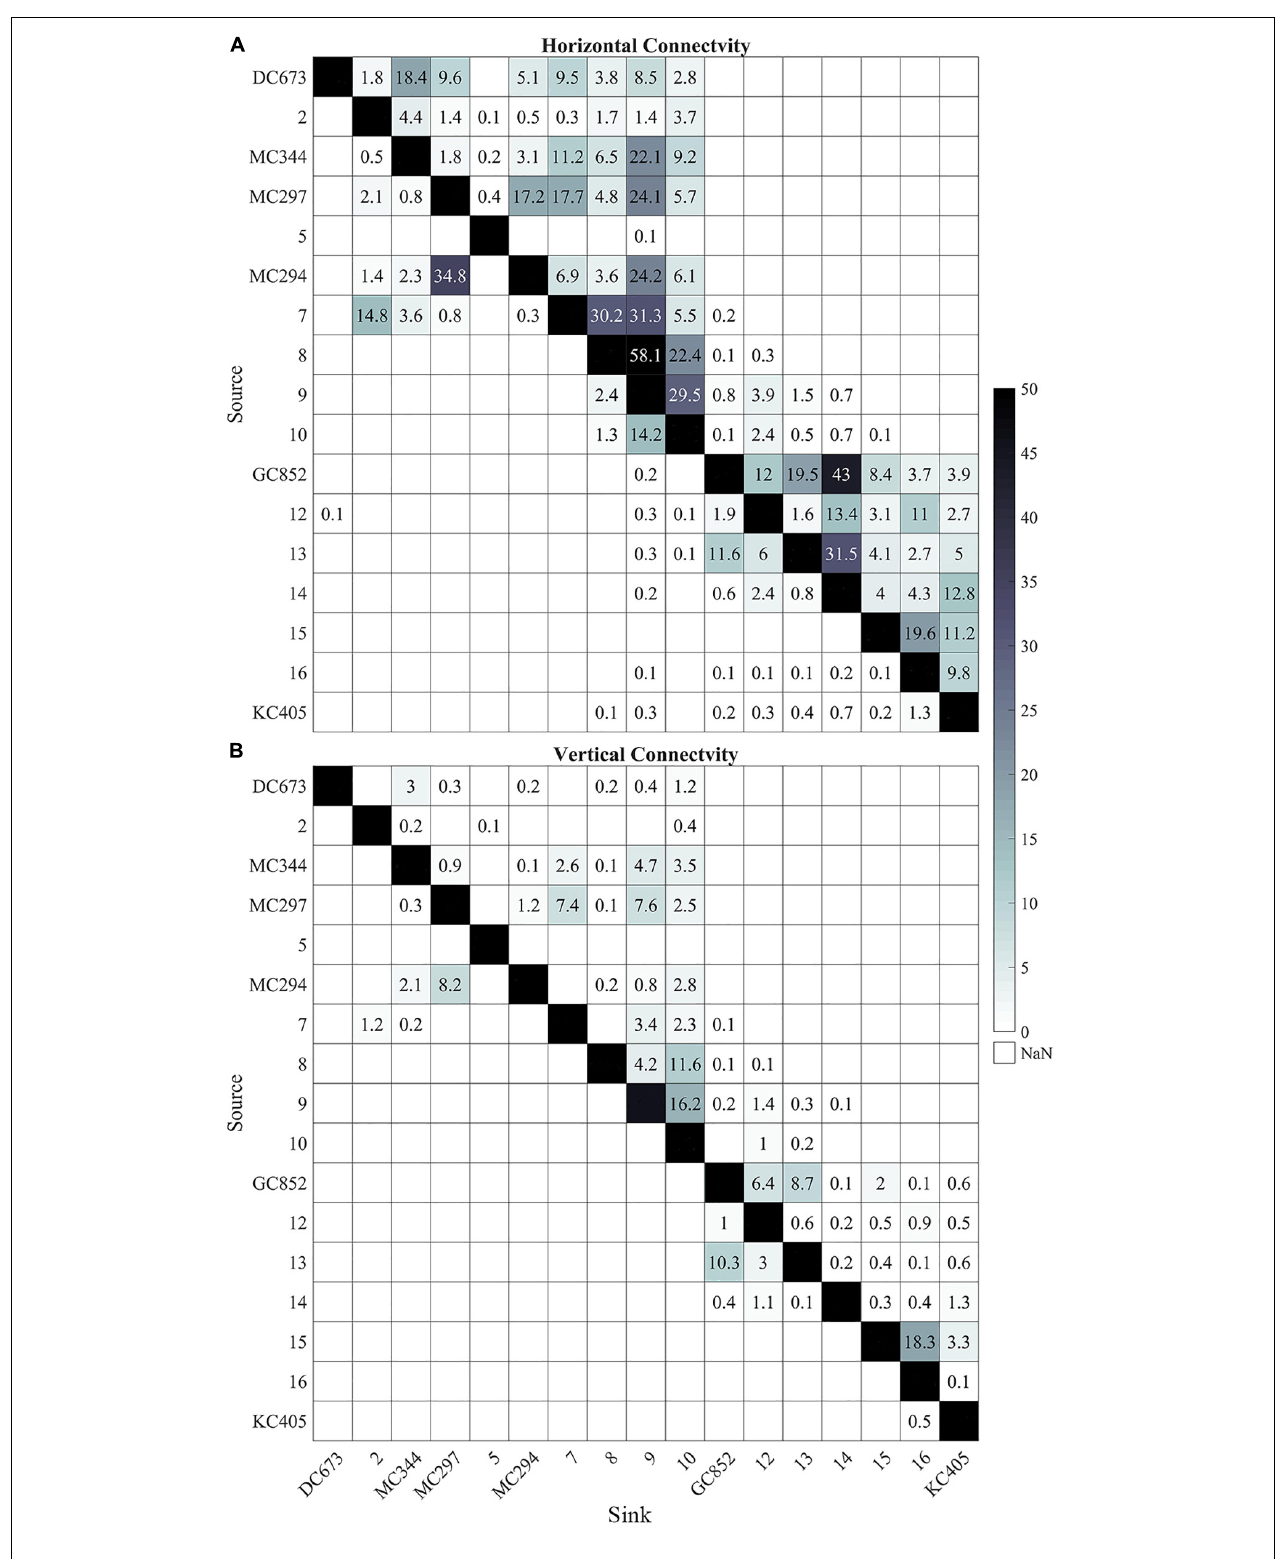
FIGURE 8 | Heat maps of horizontal l h (A) and 3D l v (B) connectivity probability (%) calculated from all 17 sites (6 sampled and 11 predicted). The connectivity is calculated from 56 days output in February, May, and August and 148 days output in November, 2015. Connectivity values below 0.1% are not shown. Sites are arranged from east to west (from DC673 to